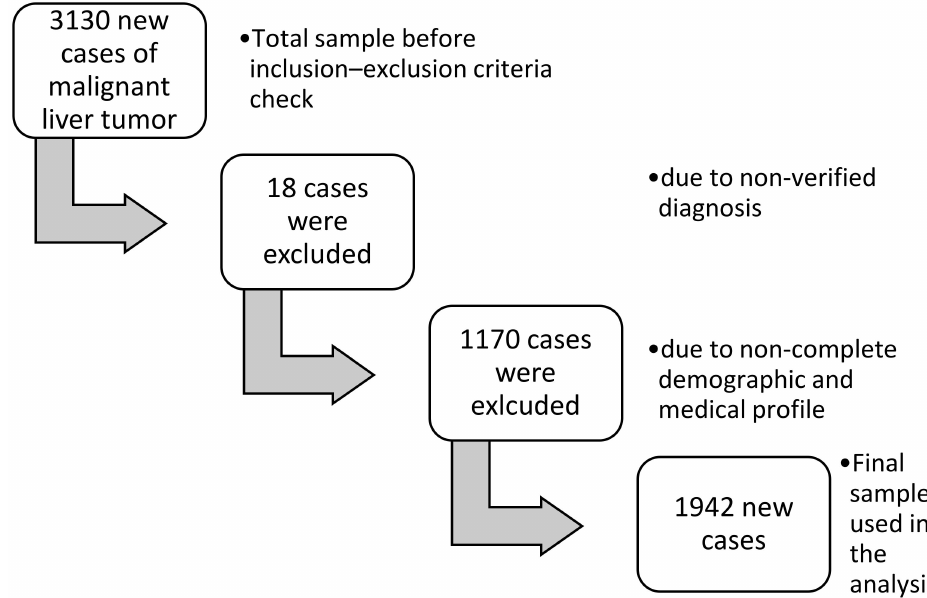
Figure 1. Flow chart depicting the sampling based on inclusion and exclusion